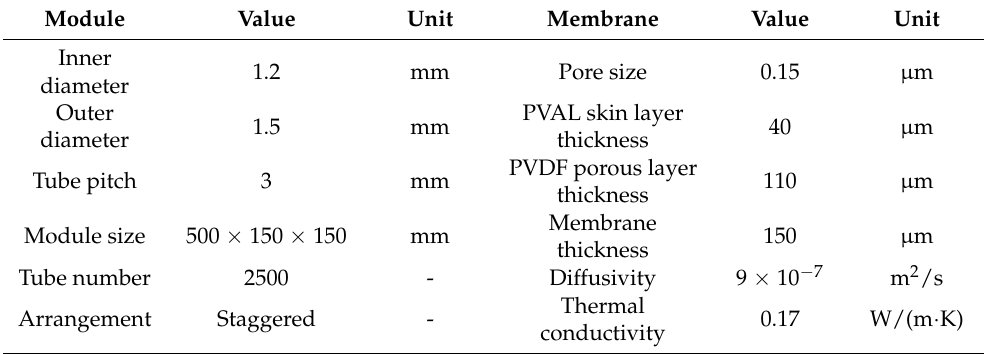
Figure 2. Experimental setup of the hollow fiber membrane evaporative cooling system: ( a ) hollow fiber membrane evaporative cooling system; ( b ) membrane module. Table 1. Parameters of the hollow fiber membrane module.